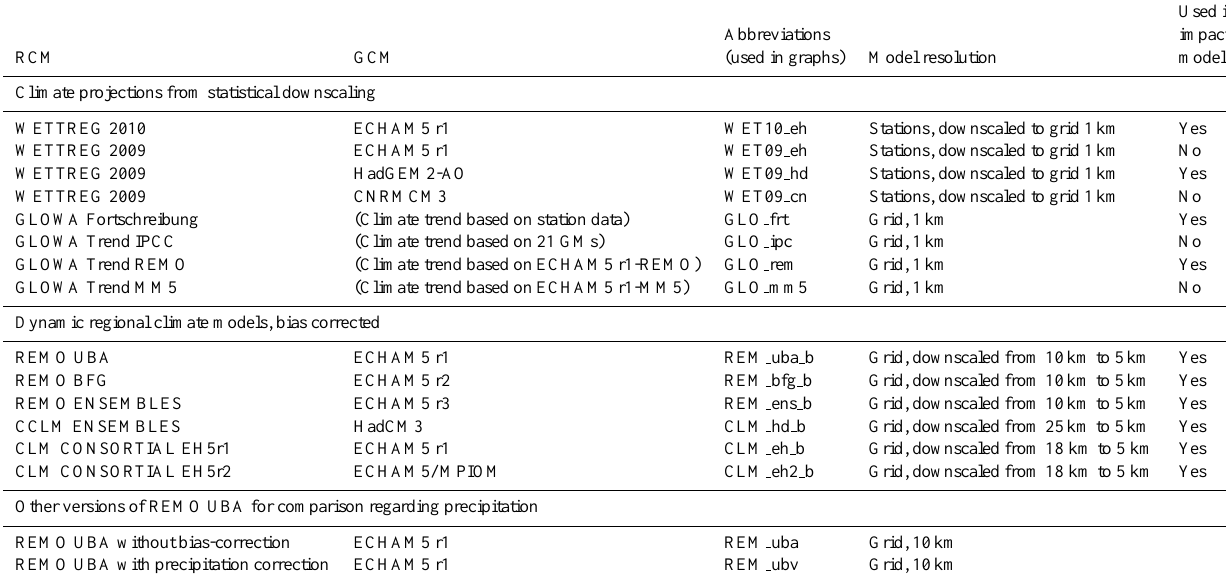
Table 1. Model chain combinations and abbreviations; analysed time periods: reference 1971–2000, “near future” 2021–2050, “distant future”